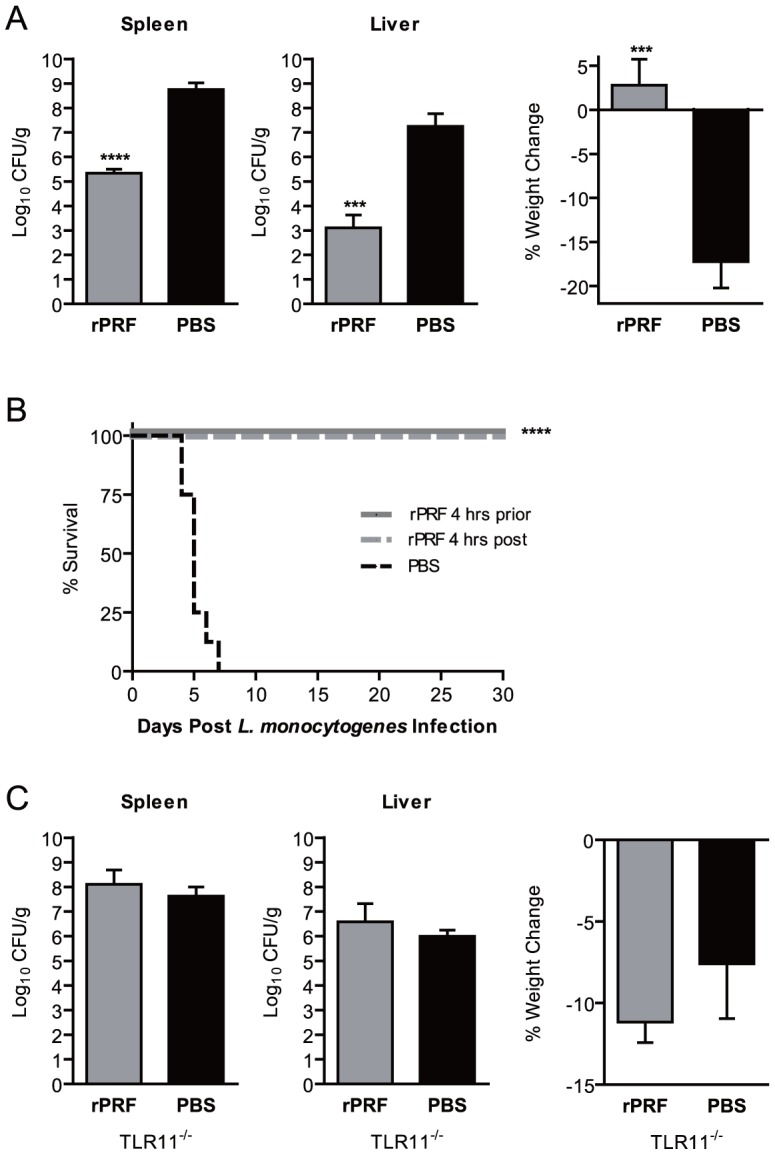
Stimulation with T. gondii profilin is sufficient to confer resistance to L. monocytogenes.(A) Mice (n = 3/group) were stimulated i.v. with 100 ng of recombinant T. gondii profilin (rPRF) (grey) or PBS (black) 4 hours prior infection with ∼6×104 CFU of L. monocytogenes. At 72 hours post L. monocytogenes infection, bacterial burdens of the spleen and liver, and percent weight change as compared to immediately prior to infection were quantified. Data shown are the mean ± SD from one of five independent experiments. *** indicates p<0.001 and **** indicates p<0.0001. (B) Survival of L. monocytogenes infected mice (n = 8/group) stimulated with PBS (dotted black) or rPRF 4 hours prior (solid grey) or post (dotted grey) L. monocytogenes infection (p<0.0001). (C) TLR11-deficient (TLR11−/−) mice (n = 4/group) were stimulated i.v. with 4 µg of recombinant rPRF (grey) or PBS (black) 4 hours prior infection with ∼4×104 CFU of L. monocytogenes. At 72 hours post L. monocytogenes infection, bacterial burdens of the spleen and liver, and percent weight change as compared to immediately prior to infection were quantified. Data shown are the mean ± SD from one of four independent experiments.